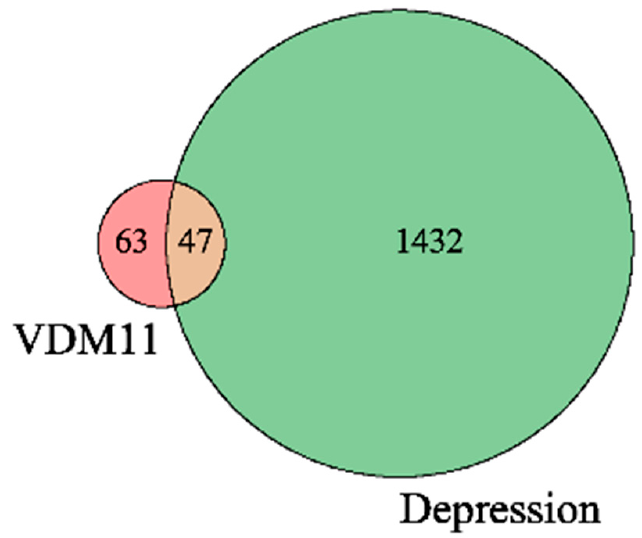
Figure 2. Overlapping genes between VDM11 and depression . The green color circle represents depression associated genes, pink color represents VDM11 targeted genes while brown color rep- resents overlapping/common genes between VDM11 and depression The overlapped proteins were uploaded to STRING version 11.5, and high-certainty interacting proteins data with a score >0.7 were accepted for the PPI network development (Figure 3). The stronger the association between the proteins corresponding to the node in the network, the higher the degree in the network interaction, indicating that the target proteins play a vital part and are deemed to be the hub genes. Based on degree values, the ten topmost hub genes were screened, including MAPK3 (22), TNF (20), IL1B (19), IL6 (19), PPARG (18), MAPK1 (17), CNR1 (13), MTOR (13), NR3C1 (11), and IGF1R (10).